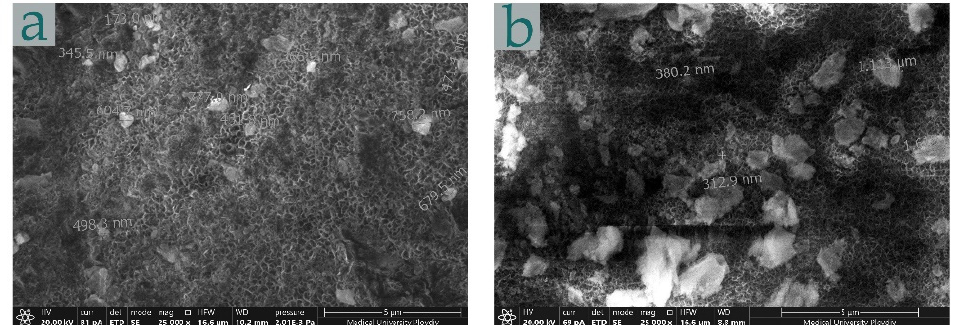
Figure 5. Microphotographs of sample of groups ( a ) AT-3 and ( b ) AT-6 (anodic oxidation for 30 min and chemical deposition for 3 and 6 min) at ×25,000 magnification.